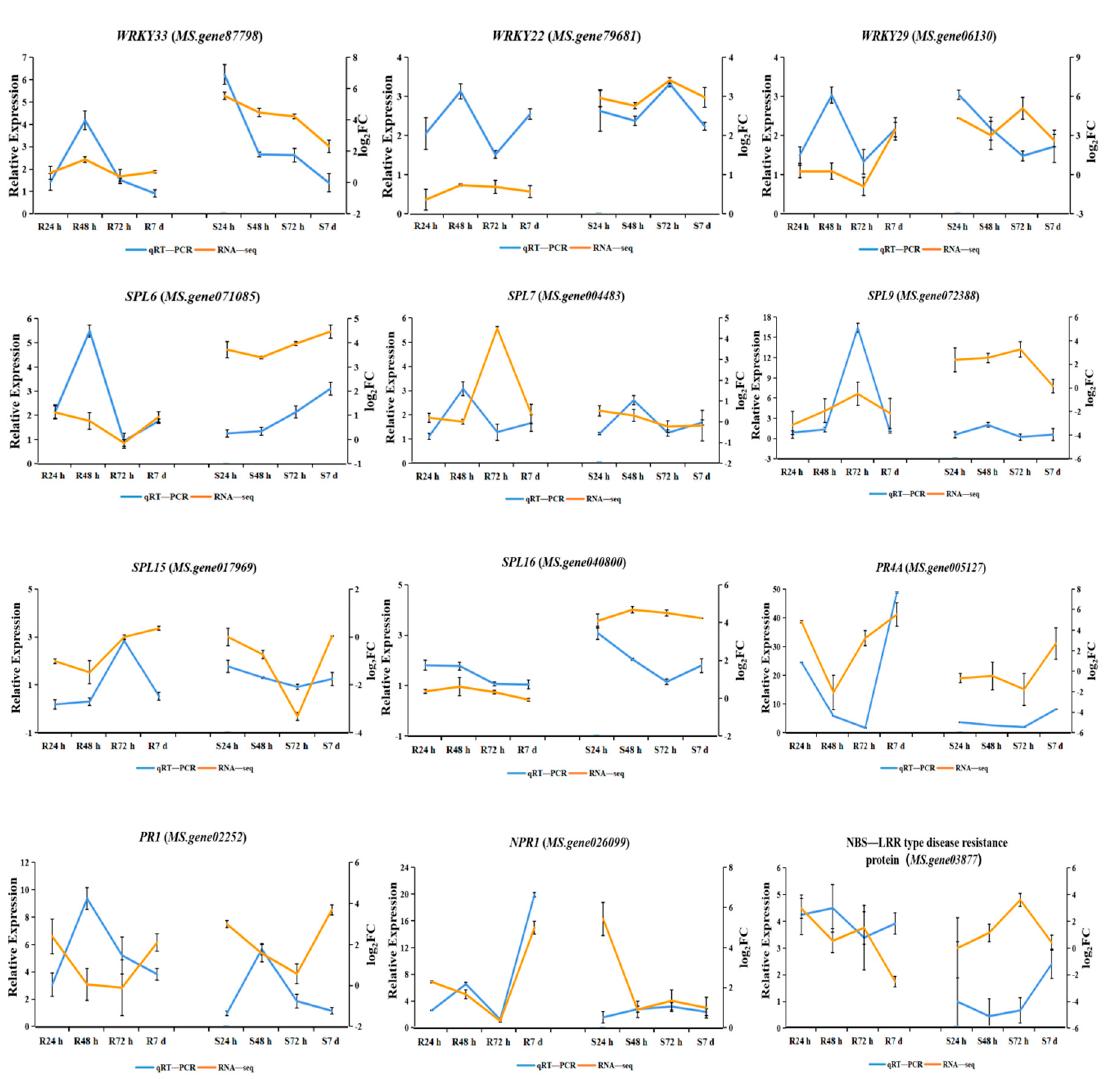
Figure 9. Validation of RNA–seq data by qRT–PCR. Blue lines represent the relative expression levels determined by qRT–PCR (left y -axis). Orange lines indicate the log 2 FC based on the read count values of the RNA–seq analysis (right y -axis). Error bars indicate standard errors of the means ( n = 3).